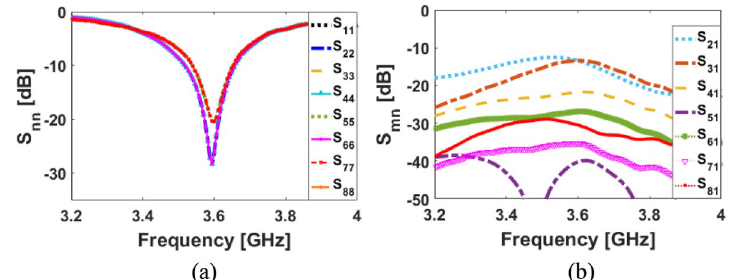
Figure 22. ( a ) S nn and ( b ) S mn results of the smartphone antenna with full GND.